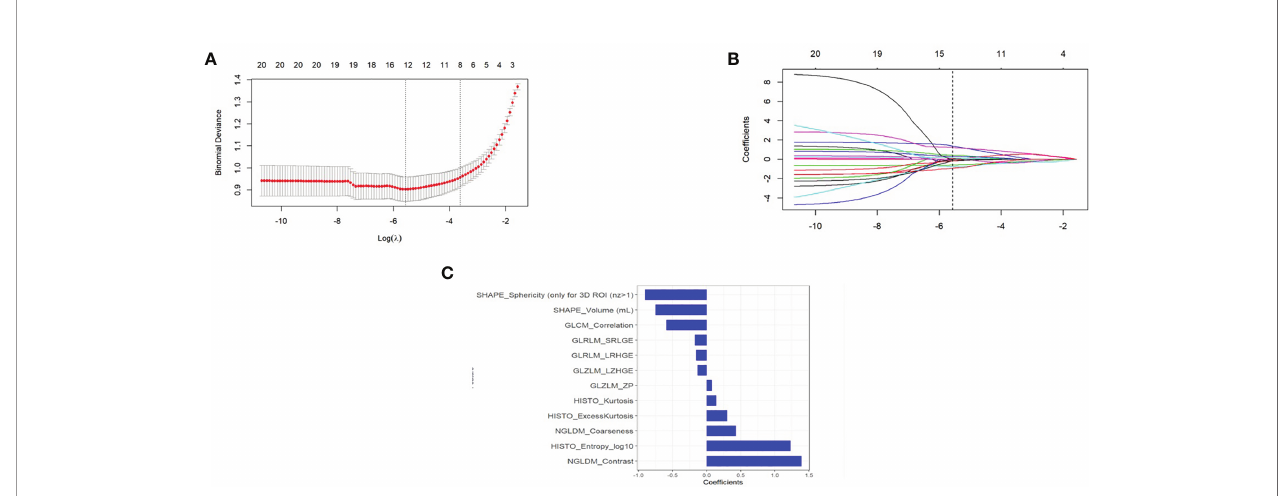
FIGURE 3 | (A) The error rate curve. (B) LASSO coef fi cient l graph. We chose the coef fi cient l with the lowest error rate. (C) The remaining features of the positron emission tomography (PET) images after feature